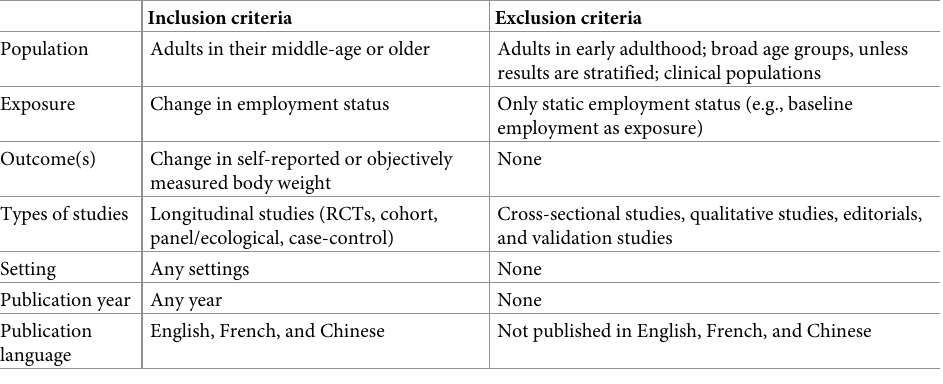
Table 2. Inclusion/exclusion criteria used.